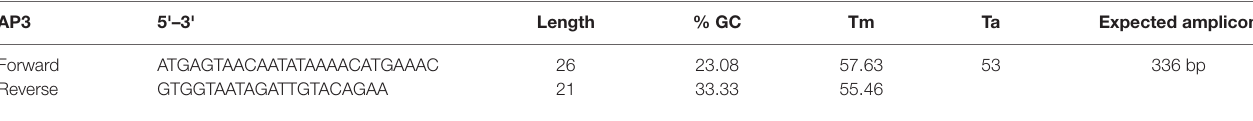
Table 1 | AP3 primers used for confirmation of V. parahaemolyticus AHPND